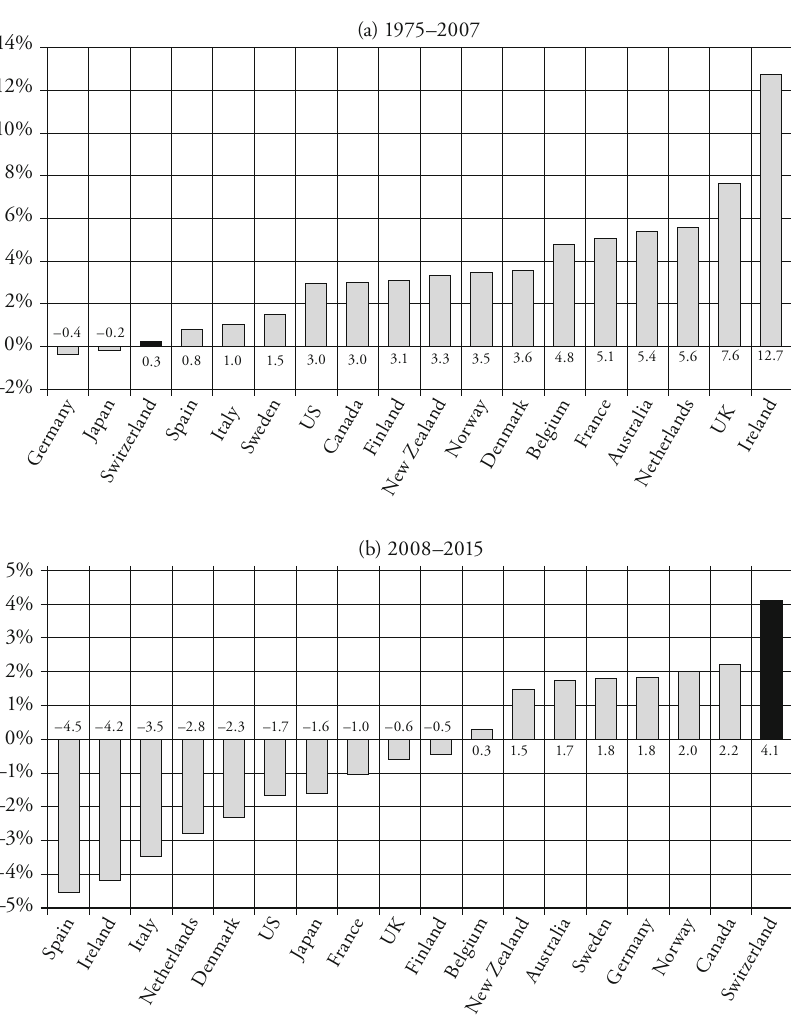
Figure 1: Real House Price